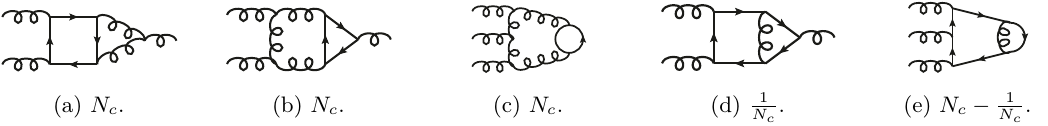
Figure 1 . Independent integral families for the gg → gγγ amplitude. The non-planar topologies appear only in the leading-colour amplitude.